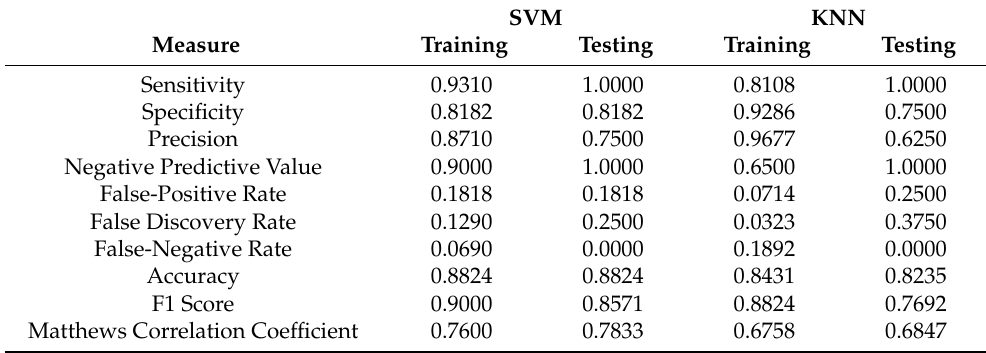
Table 3. Performance of selected features.